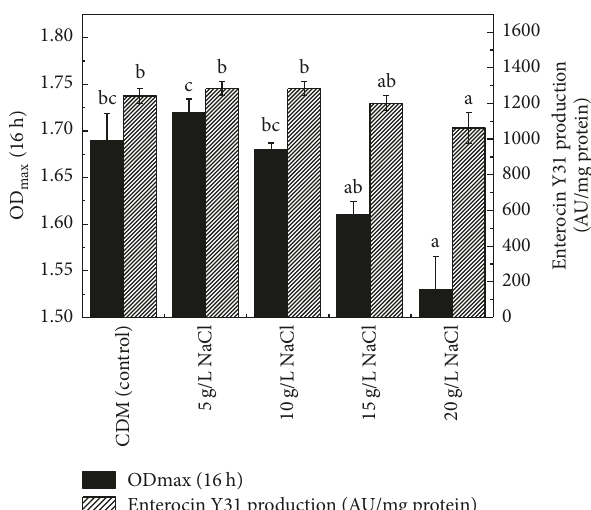
Figure 2: Effect of NaCl concentration on the growth of Enterococ- cus faecium Y31 and Enterocin Y31 production. Means not sharing a commonsuperscriptletteraresignificantlydifferentfromeachother ( 𝑃 < 0.05